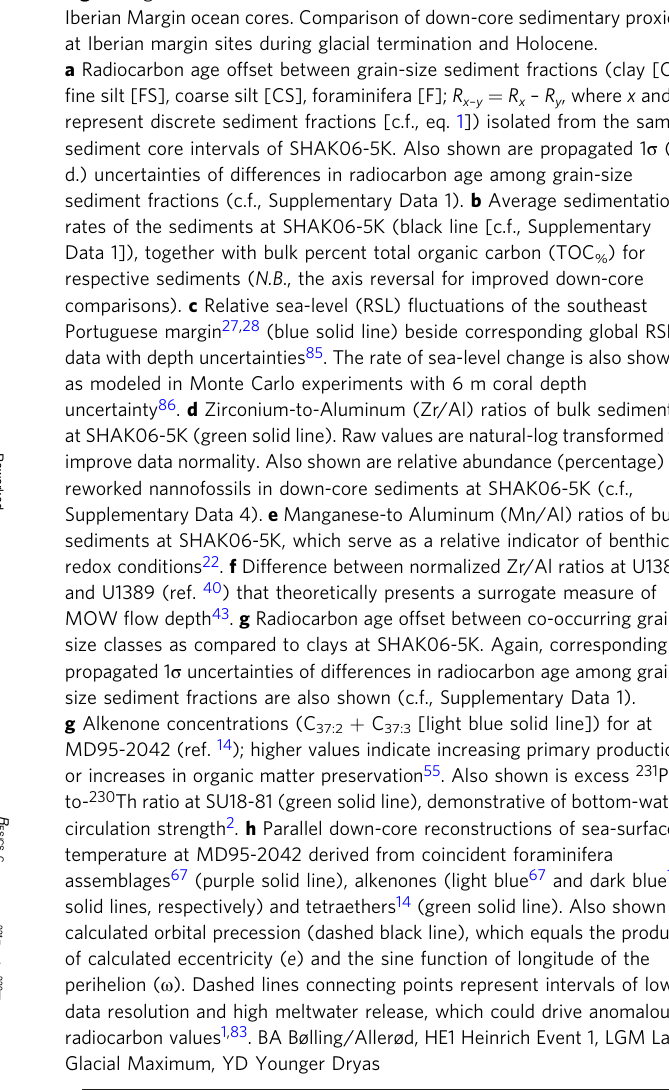
represent discrete sediment fractions [c.f., eq. 1]) isolated from the